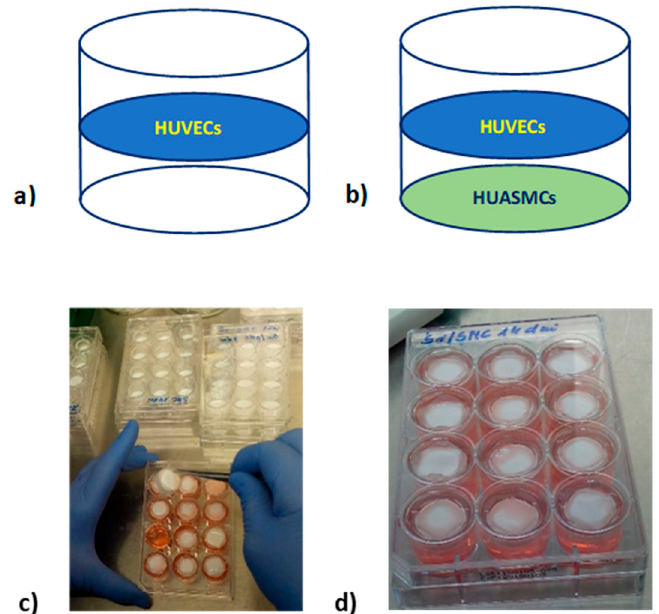
Figure 8. Culture of HUVECs seeded on the PSU membrane modified with fibronectin ( a ); co-culture of HUVECs and HUASMCs (HUVECs/HUASMCs) seeded on two flat membranes modified with fibronectin immobilized in the one insert ( b ); establishing a cell culture in a 12-well culture plate ( c ); 12-well culture plate with inserts with membranes and seeded cells ( d ).